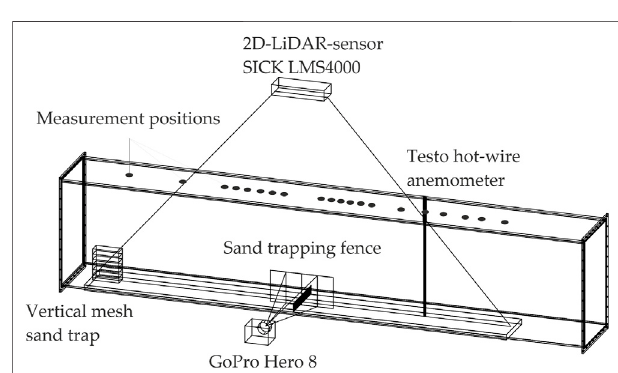
FIGURE 3 | Instrumentation setup for the test section, including 2D LiDAR sensor SICK LMS4000, Testo hot-wire anemometer for the different measurement positions, vertical mesh sand trap, and GoPro Hero